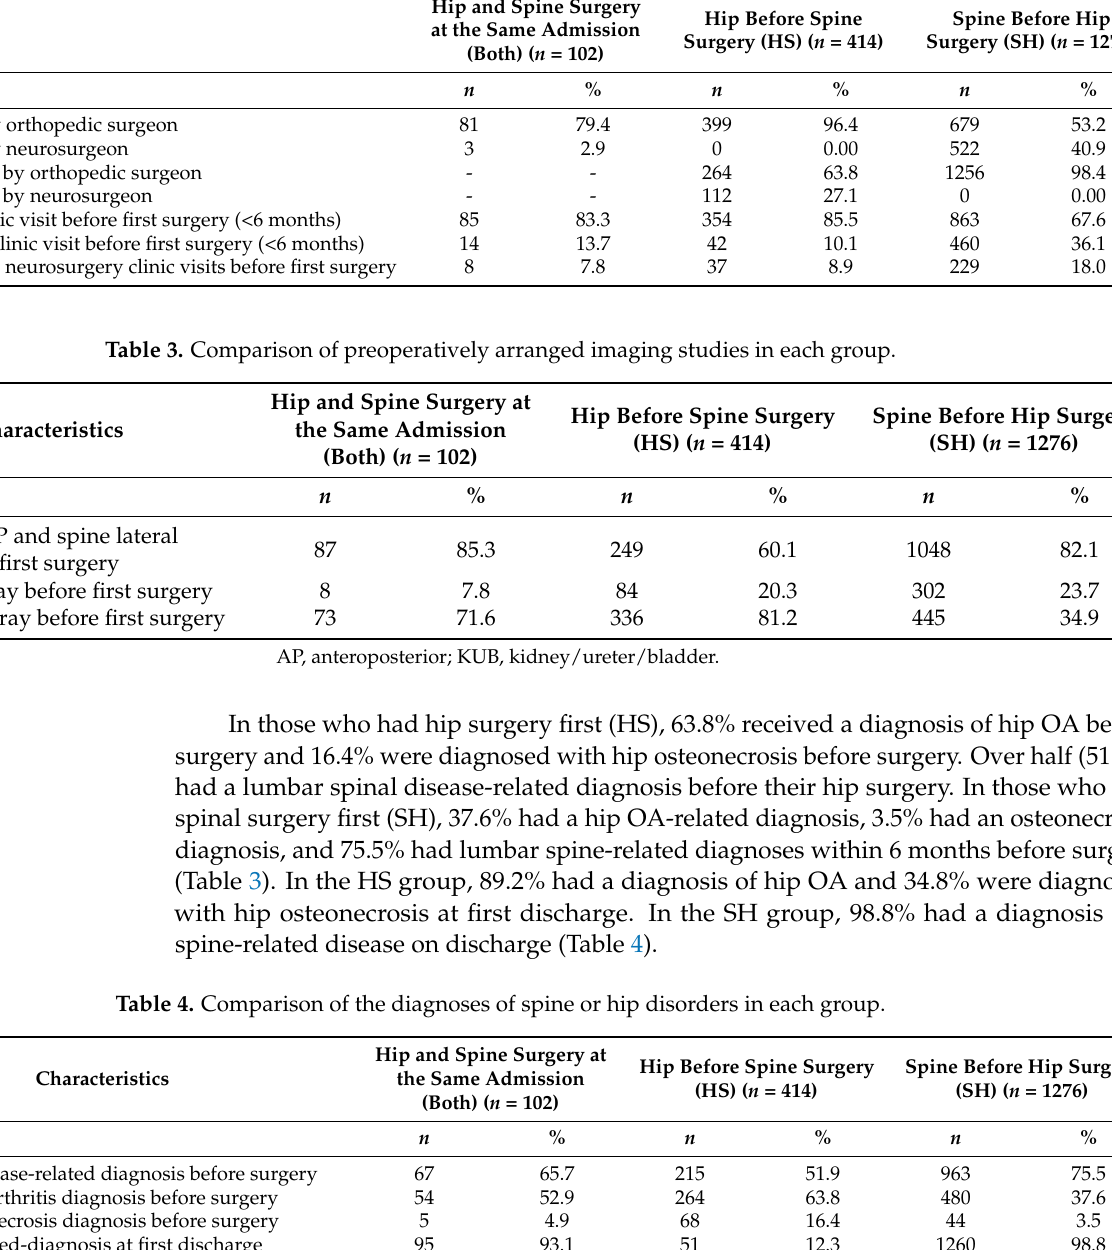
Table 2. Comparison of the numbers of surgeries performed by orthopedic surgeons and neurosurgeons.